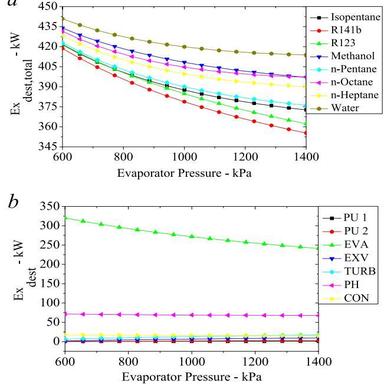
Total exergy rate as a function of evaporator pressure for different working fluids (a) exergy-destruction of the ORC-CHP components in total exergy-destruction (b) (R141b).